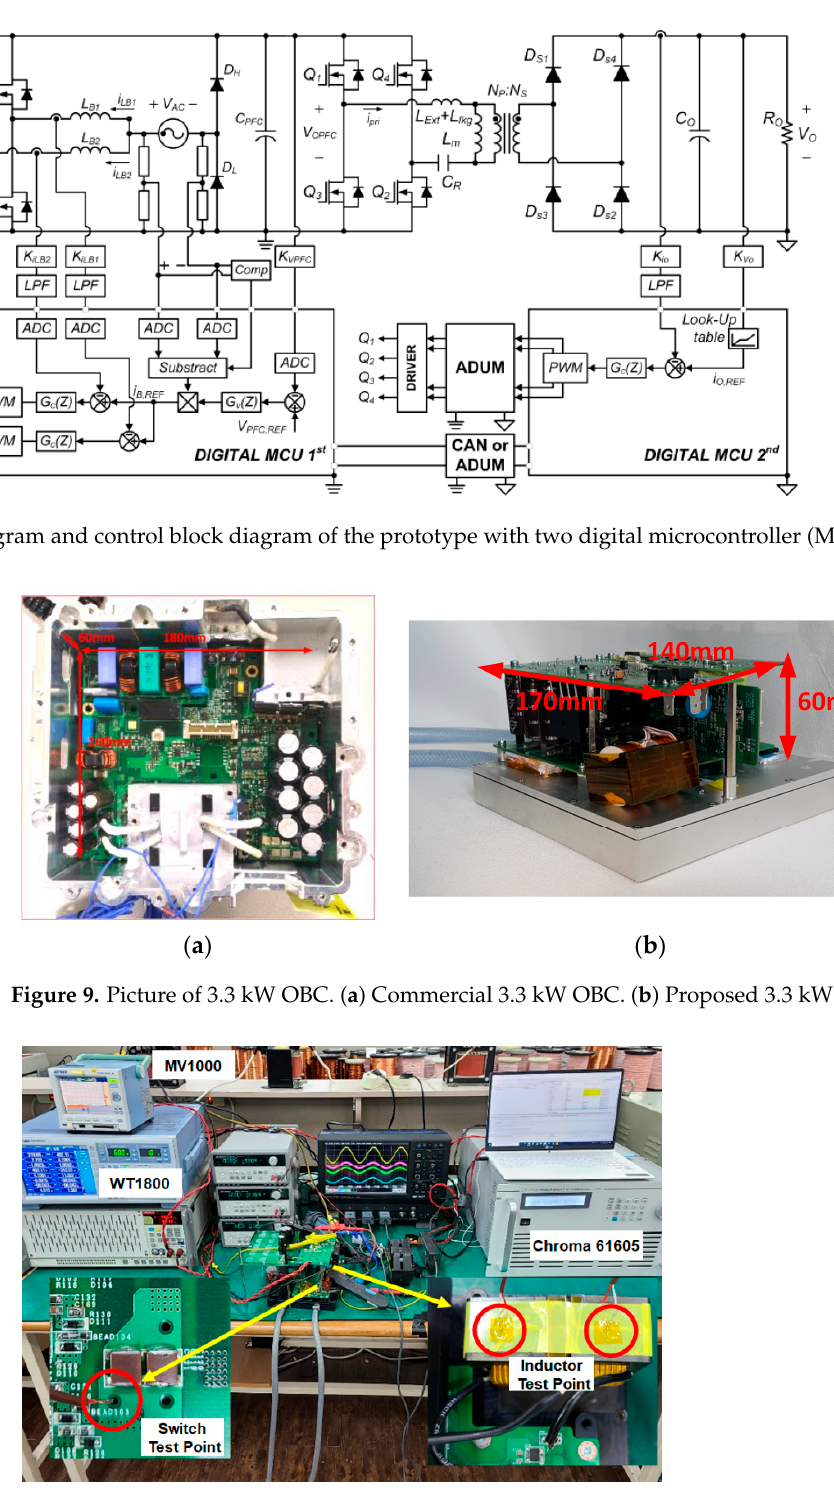
Figure 11. Captured waveforms of the prototype at 100% load condition. The modified PFC ON/OFF control is inactive above 50% load condition.